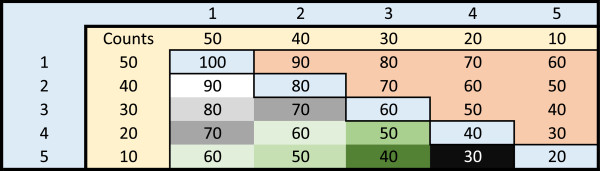
Organizing the data example. In our example, the protein has 5 residues with mutations. The residues are sorted from largest to smallest (so residue 1 has the largest number of mutations, residue 2 the second largest number of mutations, etc.), and the inside of the table is calculated as the sum of the mutations on both residues using all the samples in the study. For instance, as residue 1 has 50 mutations and residue 2 has 40 mutations, there were 90 total samples that had a mutation either on residue 1 or 2. In the actual code, only the lower half of the table is considered and then only sequentially to decrease running time, but we present the whole table here for clarity.